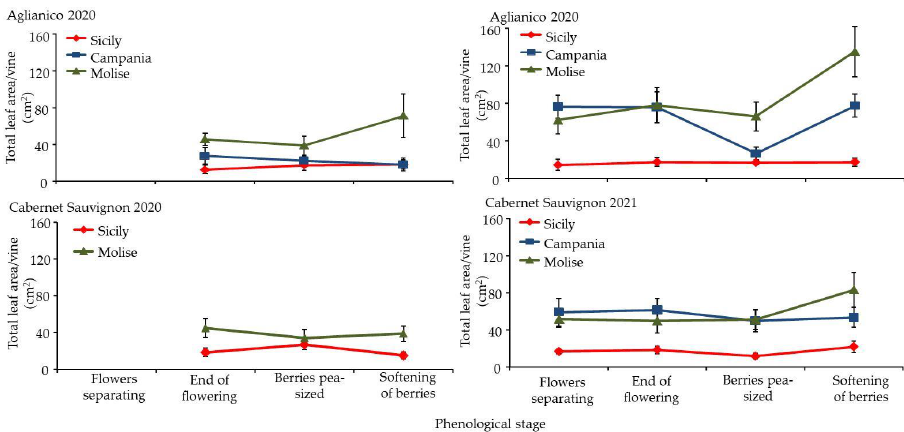
Figure 5. Total leaf areas per vine recorded in each of two cultivars, Aglianico (AGL) and Cabernet Sauvignon (CAB), grown in three different sites, Molise (MOL), Campania (CAM), and Sicily (SIC). Measurements were made at the phenological stages BBCH57 (only second year) flowers separating, BBCH69 end of flowering, BBCH75 berries pea-sized, and BBCH85 softening of berries (bars indicate one standard deviation), based on Tukey’s HSD test within sites and years.